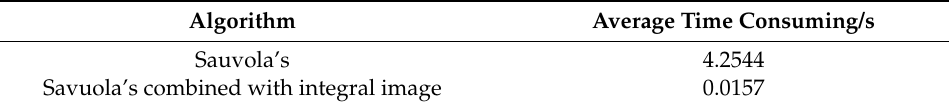
Table 1. Average consume time of the two algorithms.